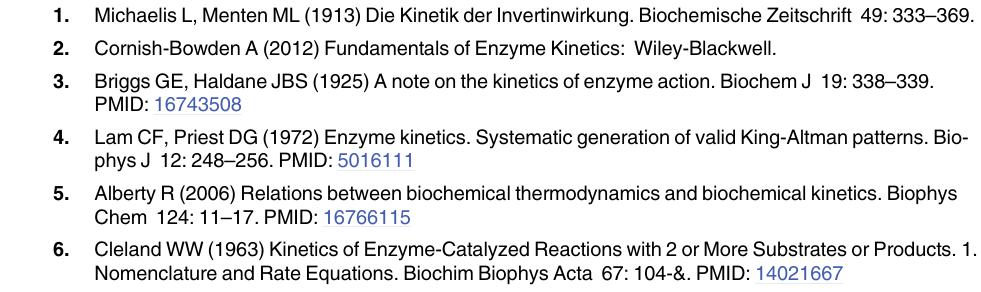
S1 Table. Definition of kinetic constants in terms of rate constants for the different mecha- nism